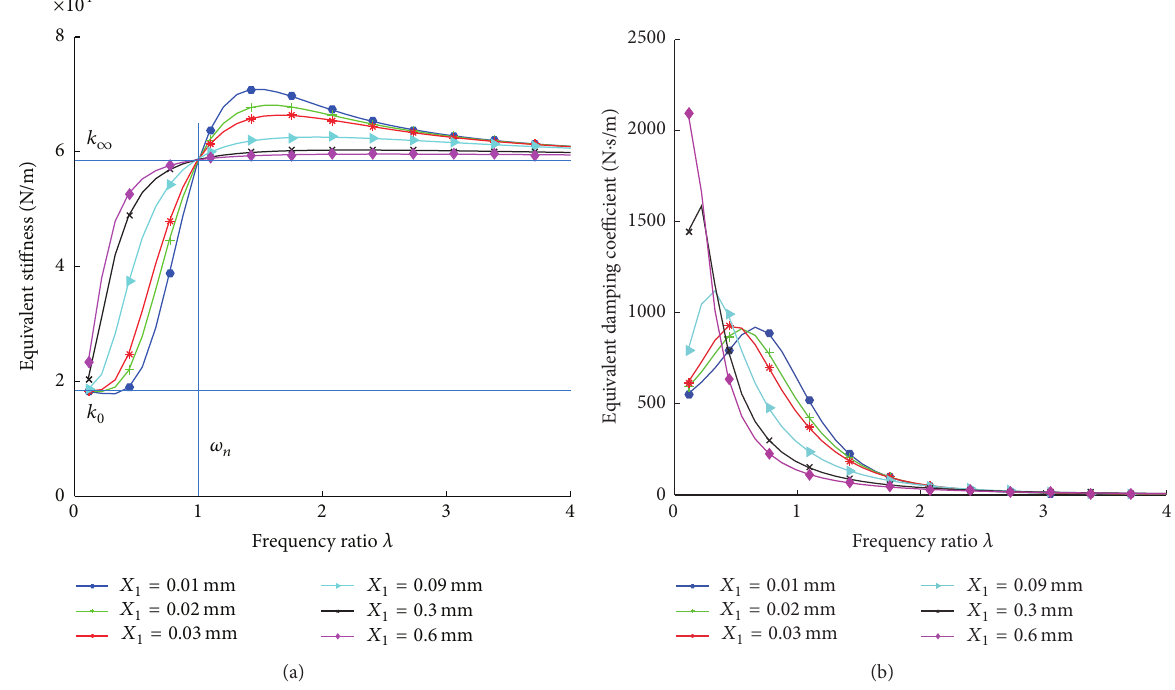
Figure 8: (a) Equivalent stiffness under different 𝑋 1 values. (b) Equivalent damping coefficient under different 𝑋 1